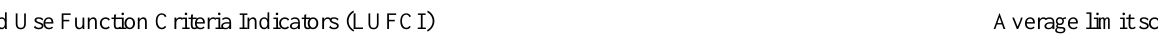
Table 6 . Analaysis of sustainability limits in Malta Land Use Function Criteria Indicators (LUFCI) Average limit